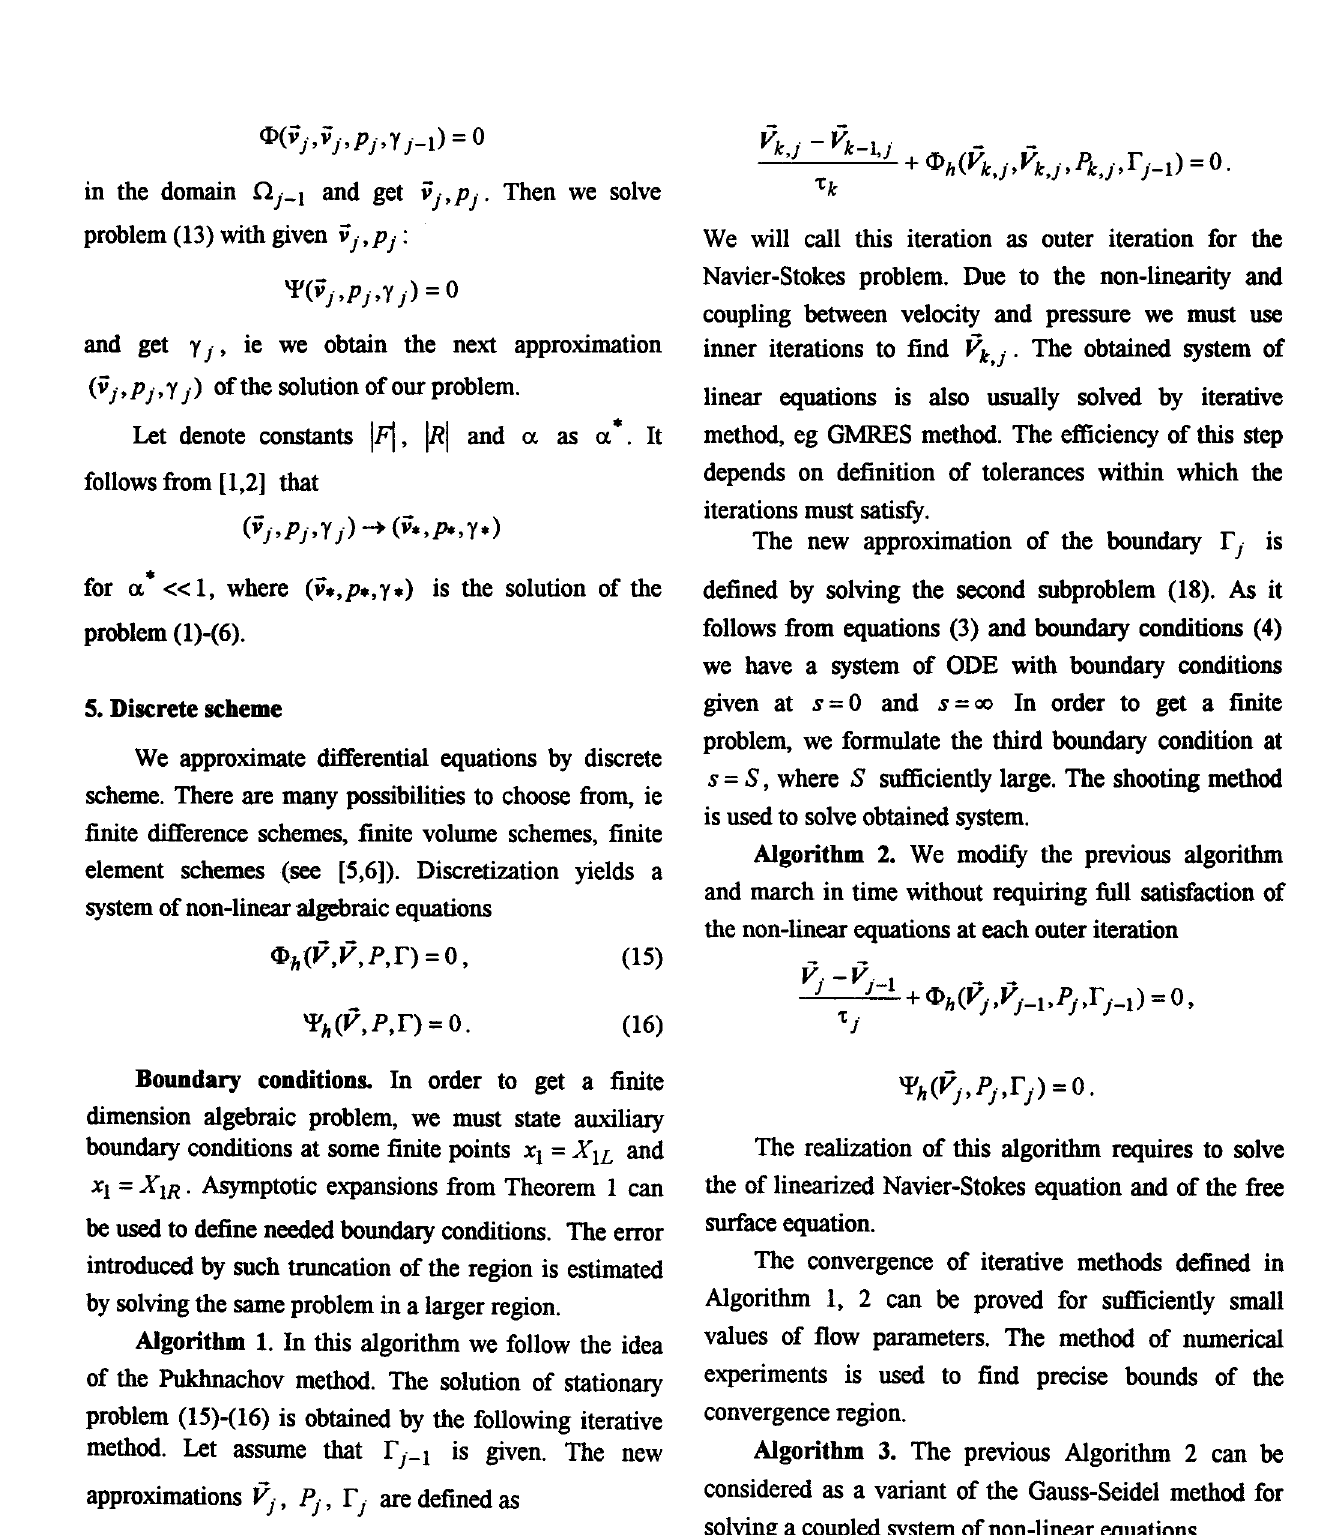
Algorithm 3. The previous Algorithm 2 can